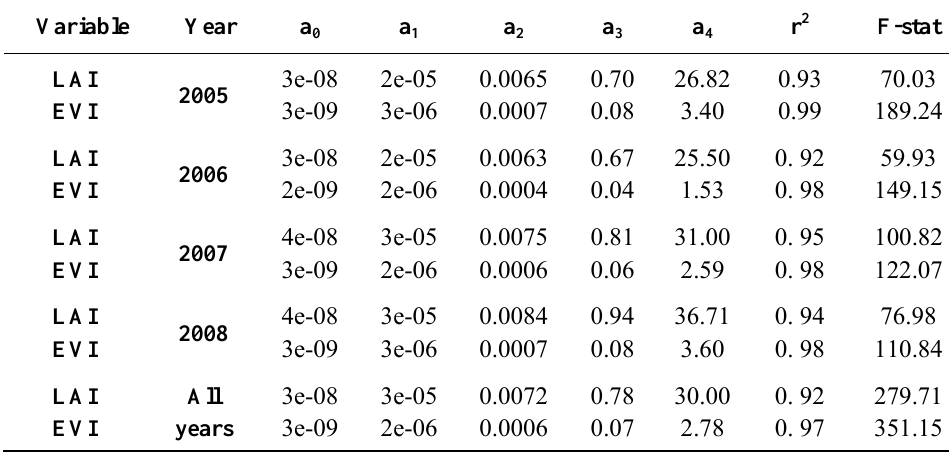
Table 1. Polynomial fit ( i.e. , y = a and y denote DOY and either LAI or EVI. In all cases considered, p -values were